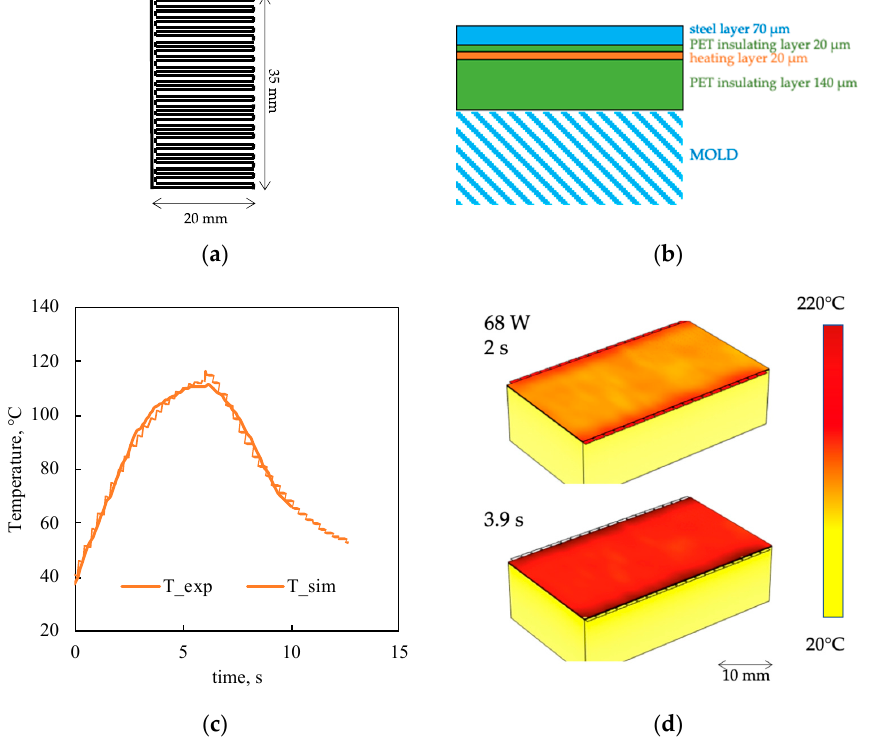
Figure 2. ( a ) Pattern of the copper heater. ( b ) Arrangement of the heater in the mold cavity. ( c ) Temperature evolution measured on the cavity, up the steel layer, for a 68 W heating power. ( d ) Simulation of the heating device’s activation for the case with a 68 W heating power (2 and 3.9 s). The heater design (distances and width among paths) was optimized through simulations. The pattern design was implemented in Comsol Multiphysics (ver. 5.6), and the heat transfer model was used. A generation term was adopted to simulate the activation. The insulating layers made of PET and the mold blocks (10 mm thickness, equal to the thickness of the cavity insert) were also included in the domain 3D geometry (number of vertex elements 480, boundary elements 83,391, elements 83,391). The properties used for each layer are reported in Table 1. A temperature of 20 °C was adopted as the initial condition in the whole domain, and continuity of the heat flux was assumed among the layers. Once the pattern was determined through simulations, the copper chip was produced with a laser beam made by using a CO 2 laser (emission wavelength at 10.6 µm) with a nominal power of 40 W. The copper layer was fixed onto an x-y plane and moved by stepping motors. A 100 mm s − 1 scanning velocity and a 100 µm spot diameter were adopted. The laser power density (P) was equal to 2.5 10 4 W cm − 2 . Table 1. Properties adopted to model the heating device. Parameters